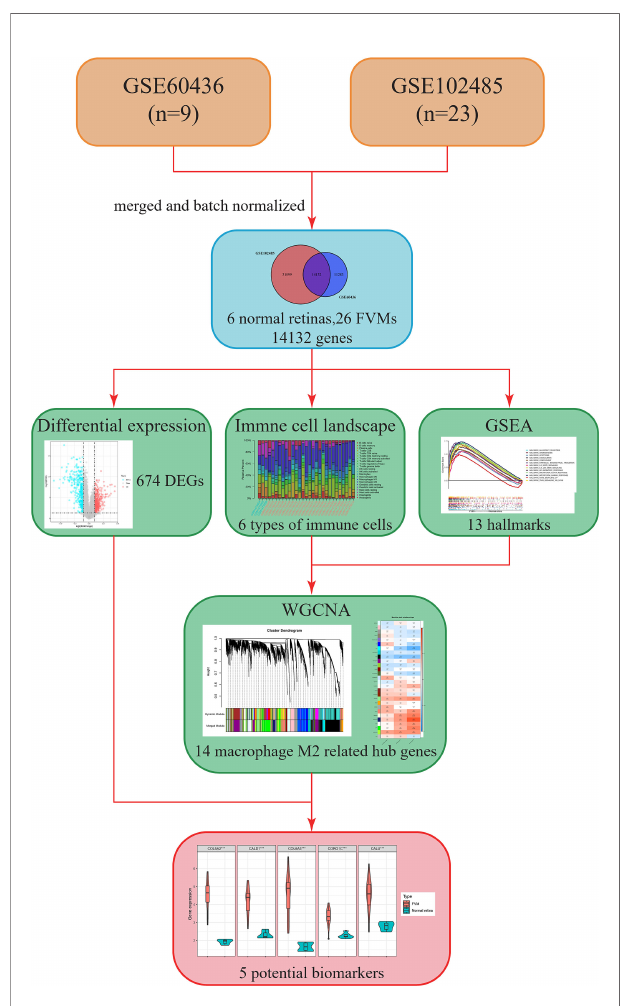
FIGURE 1 | Flow chart showing the research process in this study. FVM, fi brovascular membrane; DEG, differentially expressed gene; CIBERSORT, cell-type identi fi cation by estimating relative subsets of RNA transcripts; GSEA, gene set enrichment analysis; WGCNA, weighted gene co-expression network